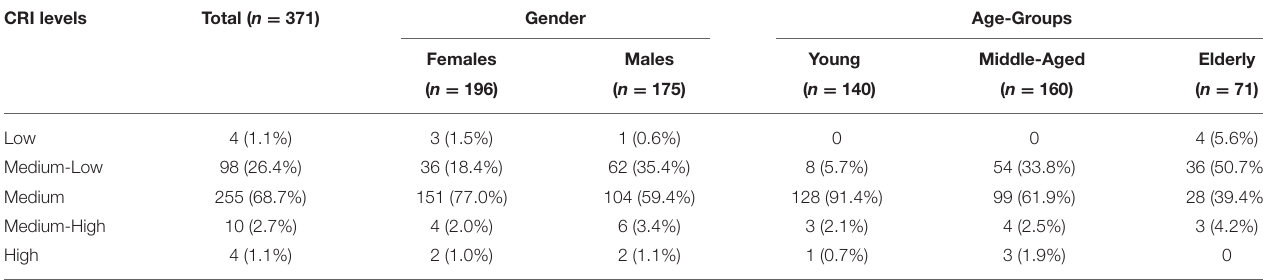
CRI, cognitive reserve index.